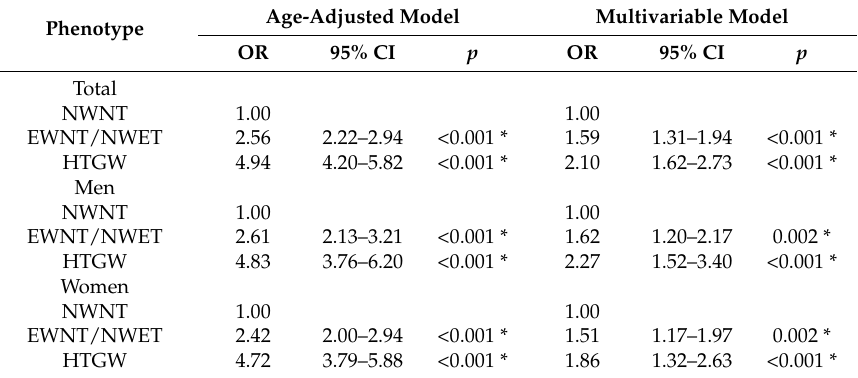
Table 3. Risk of diabetes according to the three phenotype groups for men and